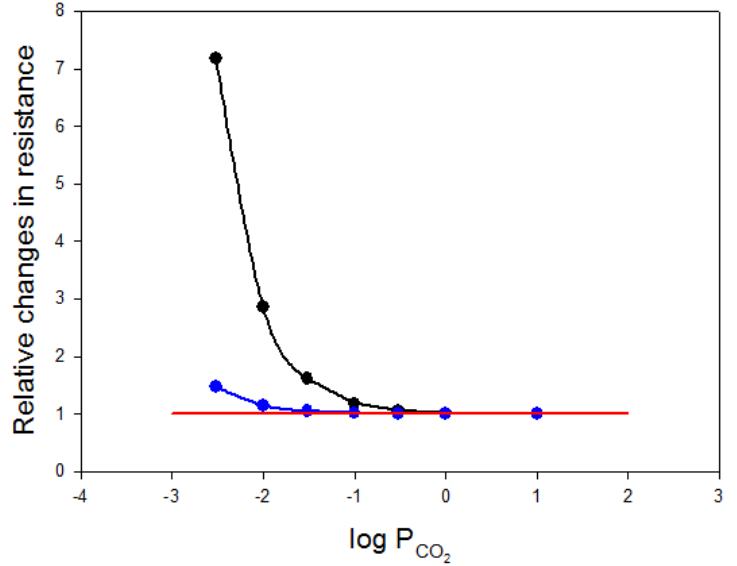
Figure 5. Relative changes in the combined diffusion resistances of 7 μm of cytoplasm and the cell membrane ( Y -axis), versus varying values of CO 2 permeability ( X -axis). Relative changes in total resistance are defined as total resistance per resistance of the cytoplasm alone. Note that P CO2 on the X -axis is plotted logarithmically and varies between 10 and 0.003 cm/s. The upper curve (black) is calculated for an intracellular CO 2 diffusion coefficient of 1.3 × 10 −5 cm 2 /s, the lower curve (blue) for a more than 10 times lower D CO2 of 0.104 × 10 −5 cm 2 /s as it has been postulated by Richardson and Swietach [2]. The horizontal red line represents total diffusion resistance for infinitely high P CO2 , i.e., the normalized cytoplasmic resistance alone. It is apparent that, for “normal” P CO2 values between 0.02 and 0.3 cm/s (Table 1), the relative contribution of membrane CO 2 permeability to the total cellular diffusion resistance becomes almost negligible for this very low cytoplasmic CO 2 diffusivity (blue curve), whereas for the “classical” diffusion coefficient of 1.3 × 10 −5 cm 2 /s (black curve) this contribution rises enormously with lower P CO2 values.